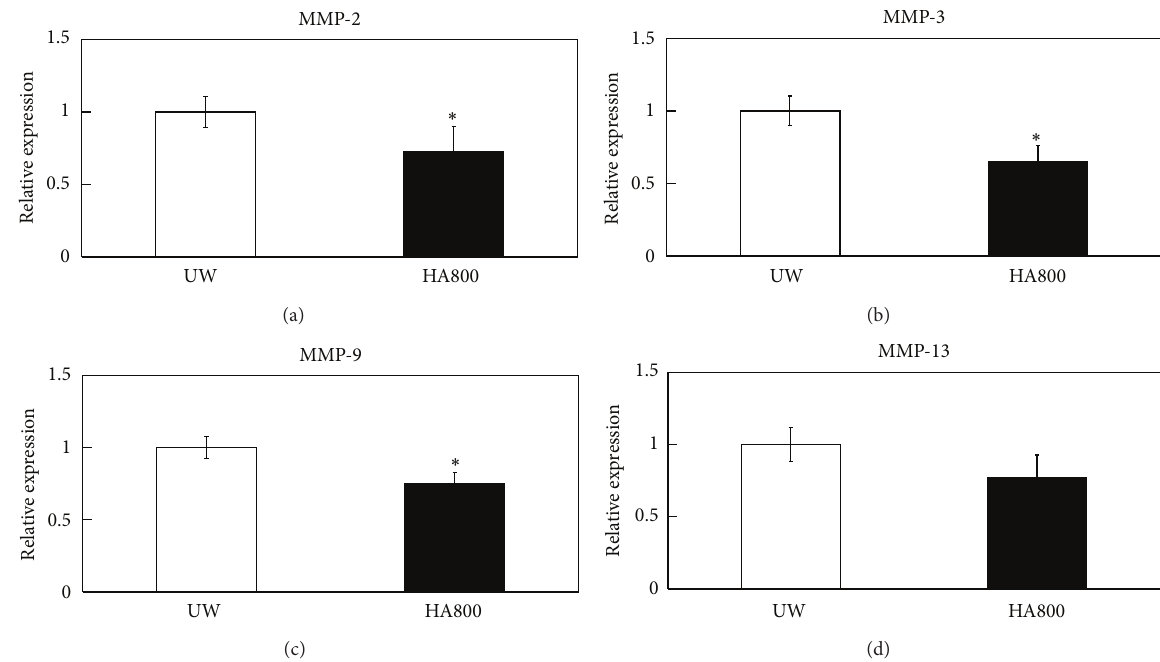
Figure 4: Real-time PCR analysis of OCTs cold preserved in the presence and absence of hyaluronic acid. Expression of MMP-2 (a), MMP-3 (b), MMP-9 (c), and MMP-13 mRNAs (d) in OCT stored for two weeks in UW solution (UW) and UW solution supplemented with 800 kDa HA (HA800). ∗ Indicating a statistically significant difference between the UW and UW with HA800 groups. All data are shown as the mean ± SE ( 𝑛 = 6